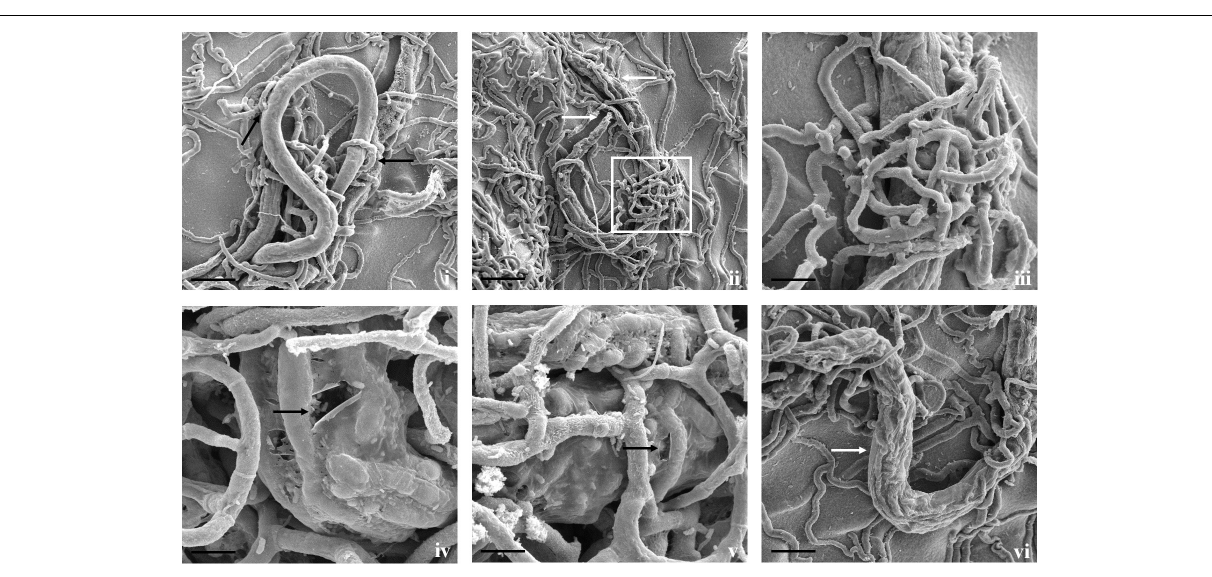
FIGURE 4 | Scanning electron micrographs of interaction between A. thaumasia At_RK and C . elegans . (i) Larva of C. elegans captured after 24 h of interaction (scale bar = 20 µ m), (ii) fungal colonization outside nematode body, traps adhered to cephalic and tail regions of C. elegans 3 days after predation (scale bar = 50 µ m), (iii) magnification of area highlighted (panel ii) showing nematode captured by fungal adhesive trap (scale bar = 10 µ m), (iv,v) fungus rupturing nematode cuticle (black arrows) (scale bar = 10 µ m), (vi) fungus growing inside nematode body (white arrows) (scale bar = 20 µ